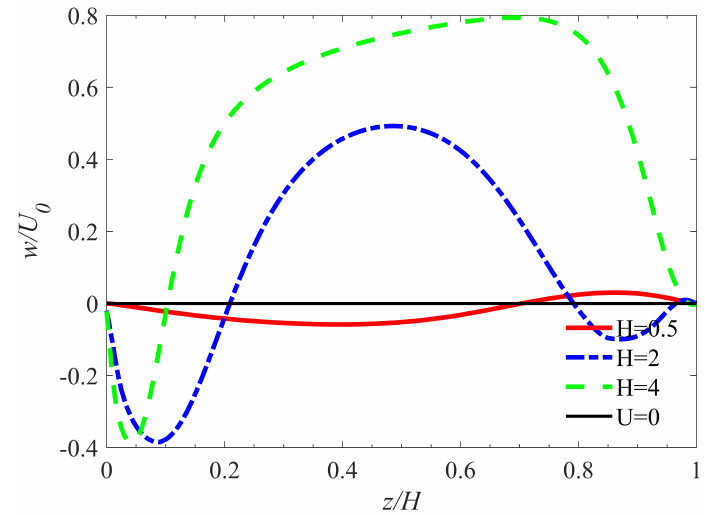
Figure 8. Axial velocity along the axis for the straight nozzle.